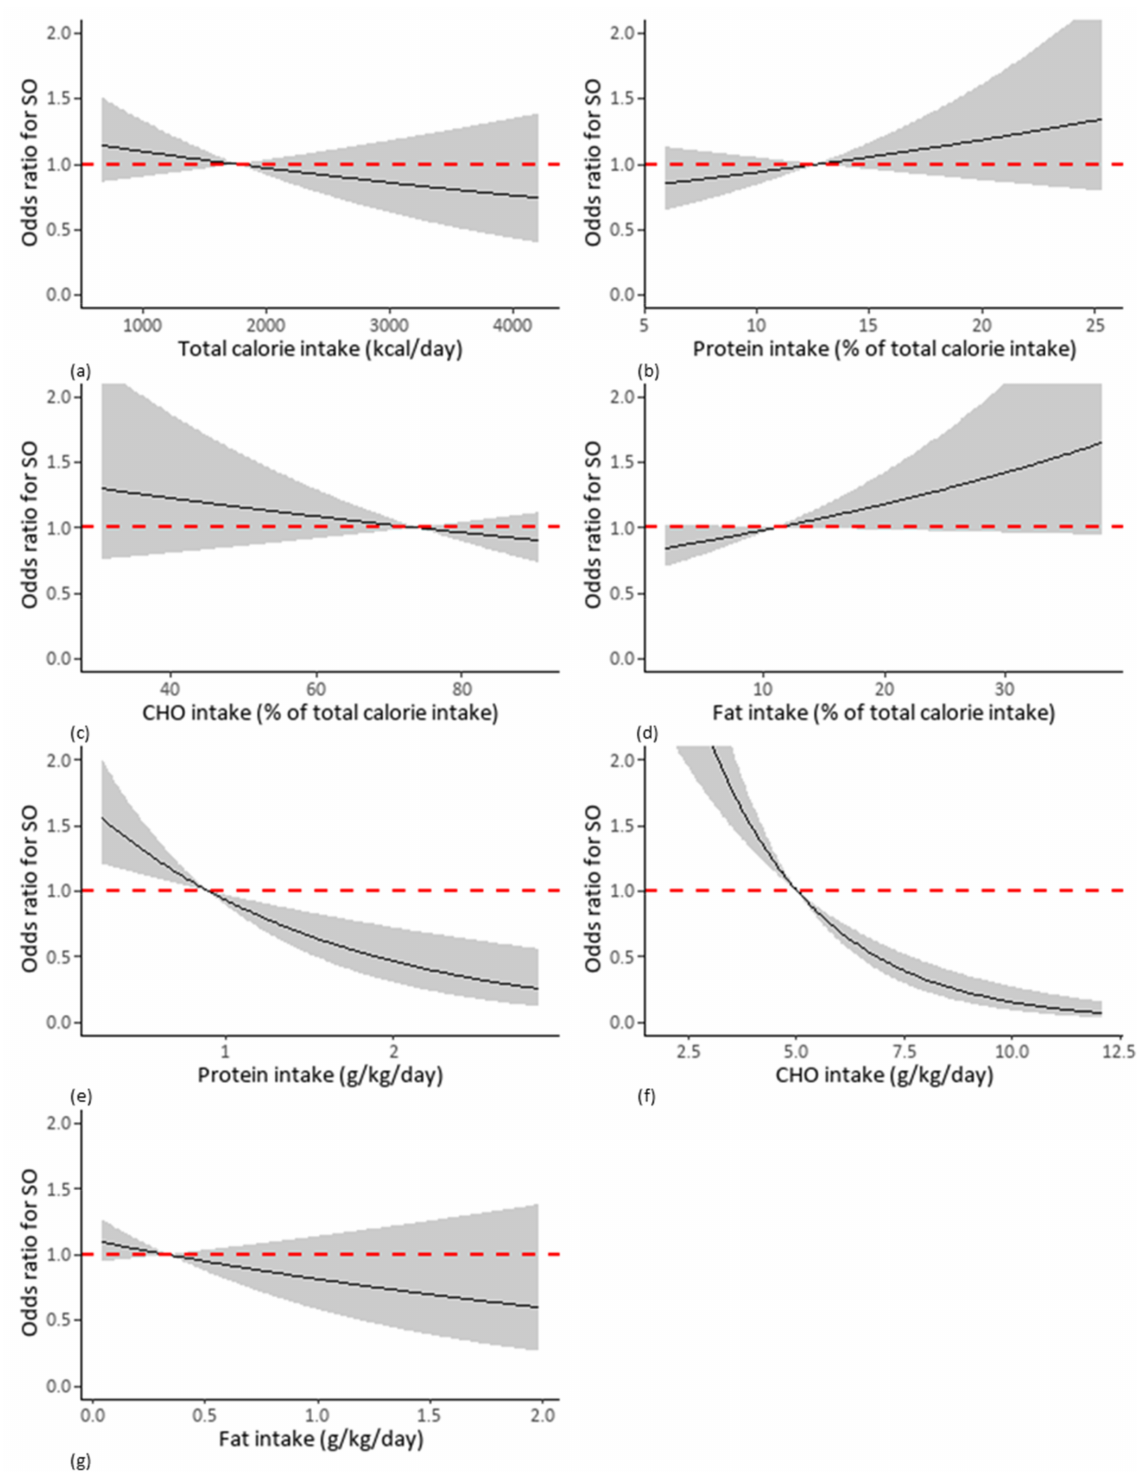
Figure 3. Cubic spline curves showing relationship between OR for SO and each pattern of macronutrient intake in men. Each pattern of macronutrients intake consists of ( a ) total calorie intake (kcal/day), ( b ) percentage of calorie intake from protein intake, ( c ) percentage of calorie intake from CHO, ( d ) percentage of calorie intake from fat, ( e ) protein intake per body weight, ( f ) CHO intake per body weight, ( g ) fat intake per body weight. Abbreviations: OR, odds ratio; SO, sarcopenic obesity; CHO,